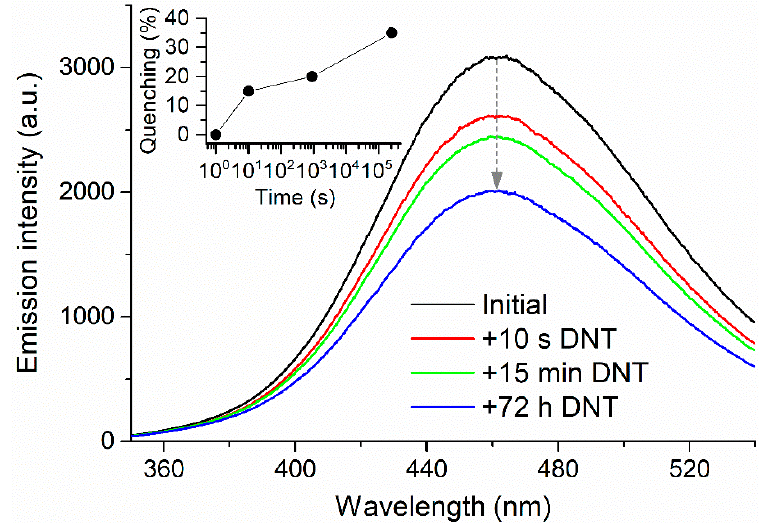
Figure 8. Exposure of [Zn 2 (bpdc) 2 (bpee)] soft-imprinted on CA/quartz at 4 bar to DNT vapors. Inset: quenching percentages for each exposure time.